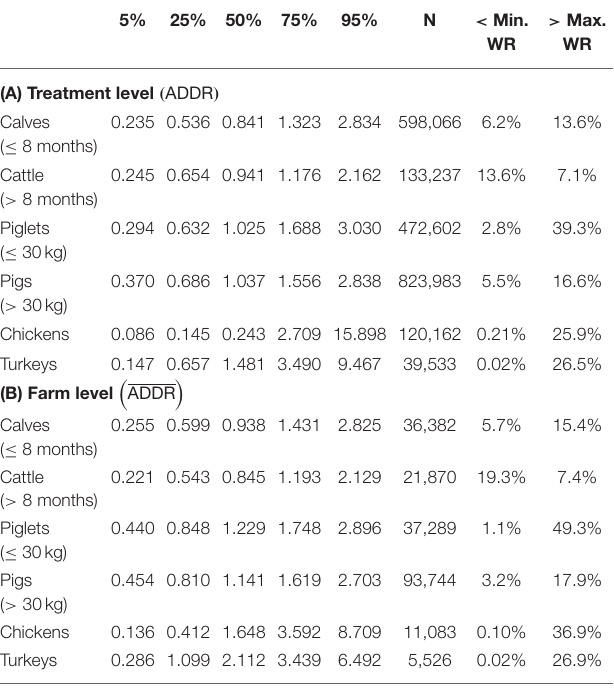
TABLE 3 | Quantiles of the distributions of (A) treatment-level animal daily dose ratios, ADDR, and (B) farm-level average animal daily dose ratios,